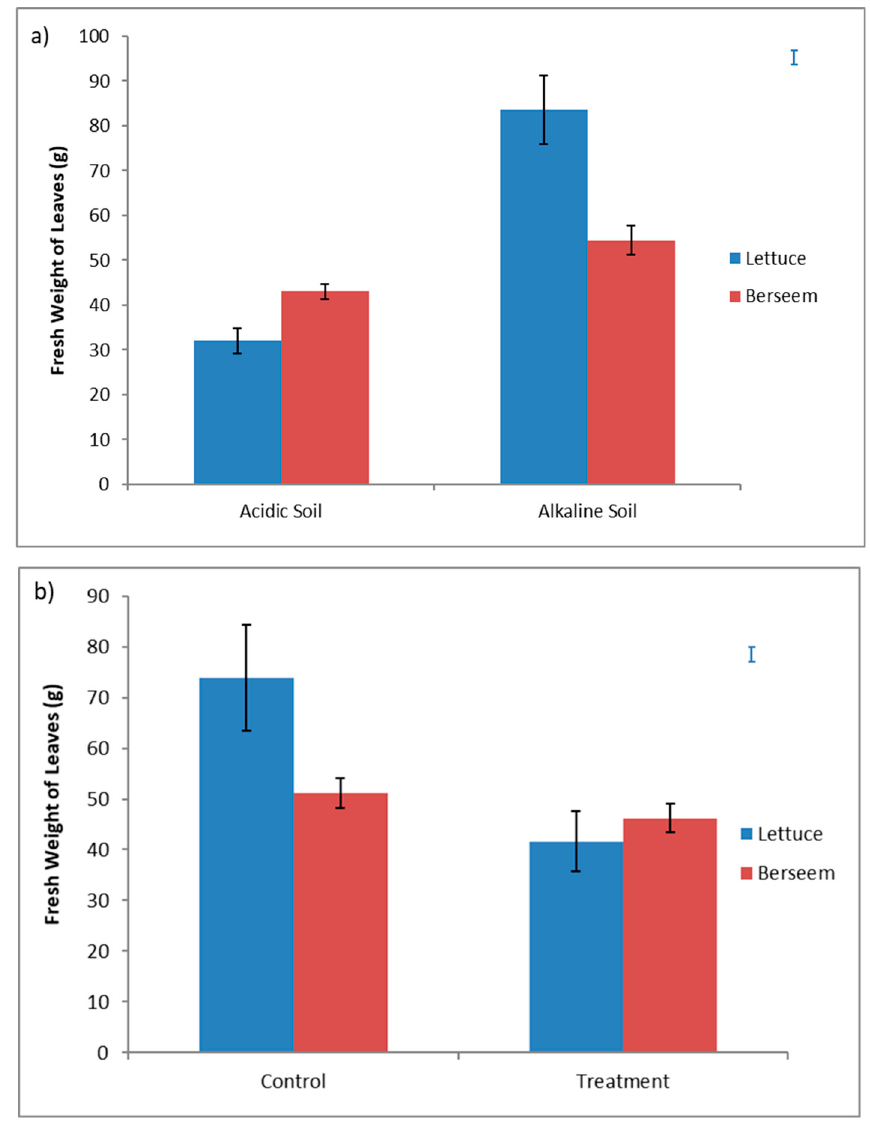
Figure 1. Effects of various factors on fresh weight of leaves; ( a ) cultivation vs. soil type; ( b ) cultivation vs. Se treatments. In each column the bar on it represents the standard error of the mean. Bars at the right side of the graphs are the standard error of the ANOVA analysis.